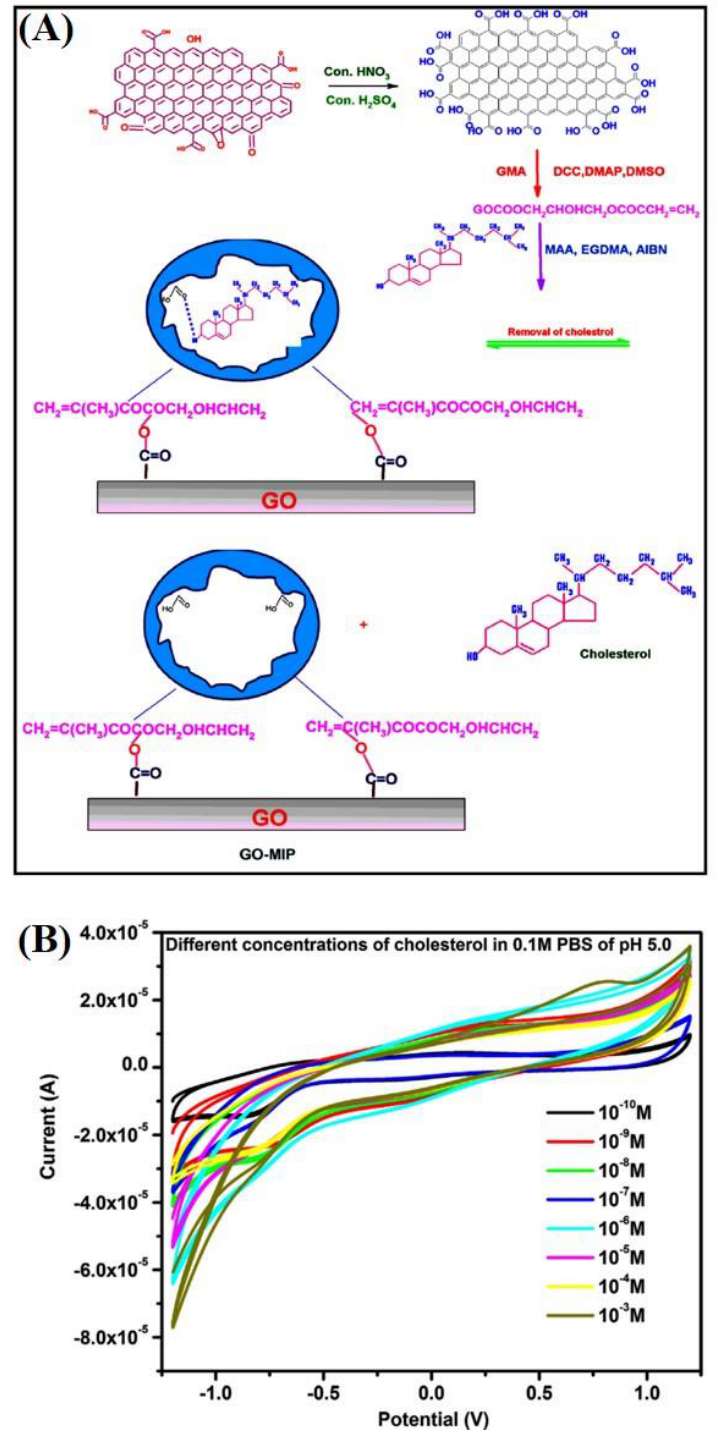
Figure 6. ( A ) Schematic representation of the formation of GO–MIP, ( B ) cyclic voltammogram of GO–MIP for different concentration of cholesterol [48]. Reprinted with permission from ref. [48]. Copyright 2017 Elsevier.